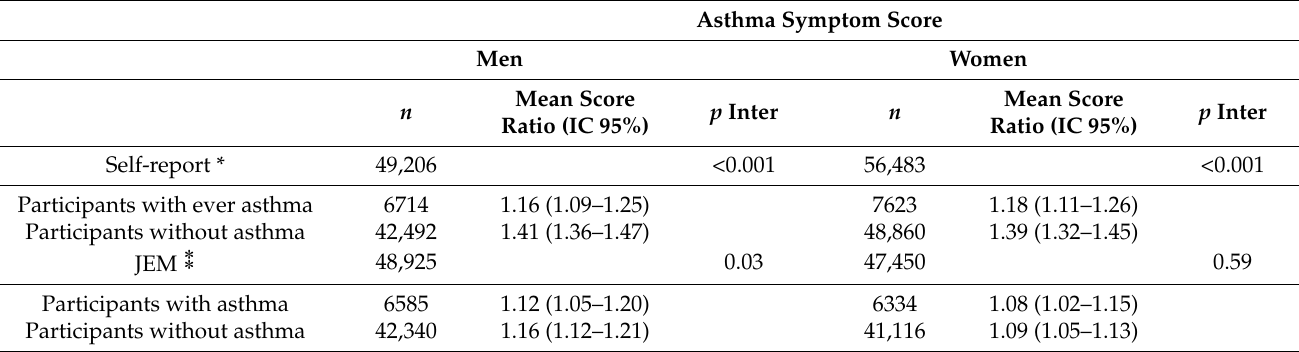
Table 4. Lifetime exposures to solvents and asthma symptom score stratified by ever asthmatic status.